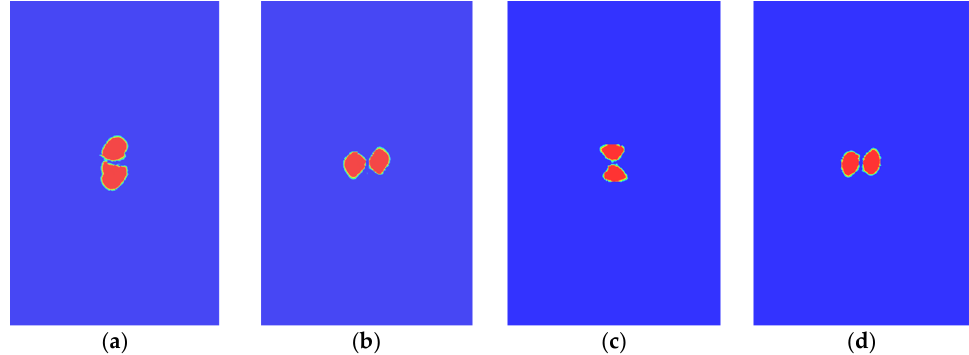
Figure 8. Delamination of typical interfaces. ( a ) The 15th interface. ( b ) The 18th interface. ( c ) The 20th interface. ( d ) The 26th interface.